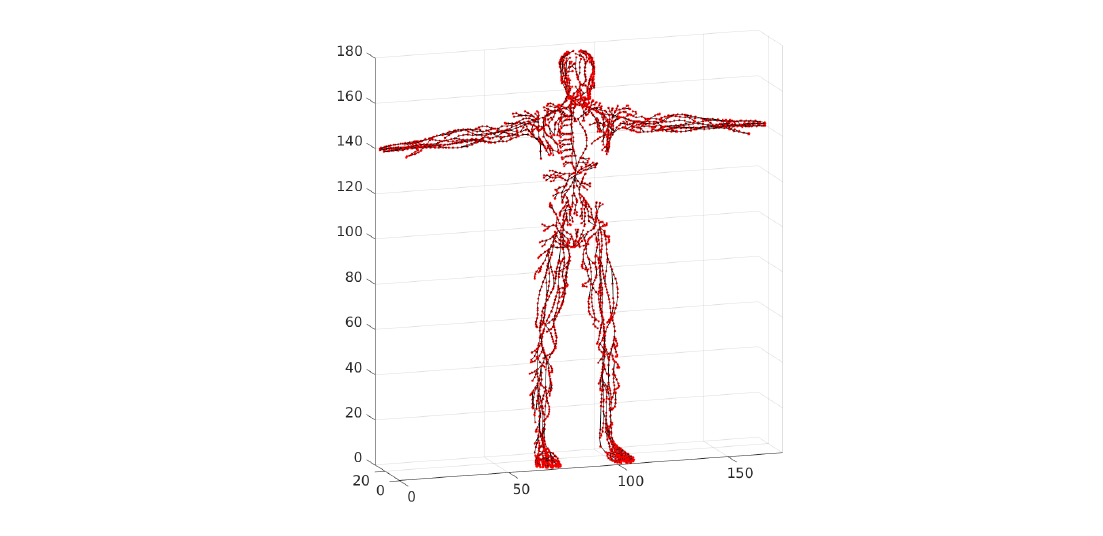
Figure 10. The basis graph of the lymphatics system network. Red color refers to graph vertices; black color refers to graph edges. The physical scale is in centimeters (cm).